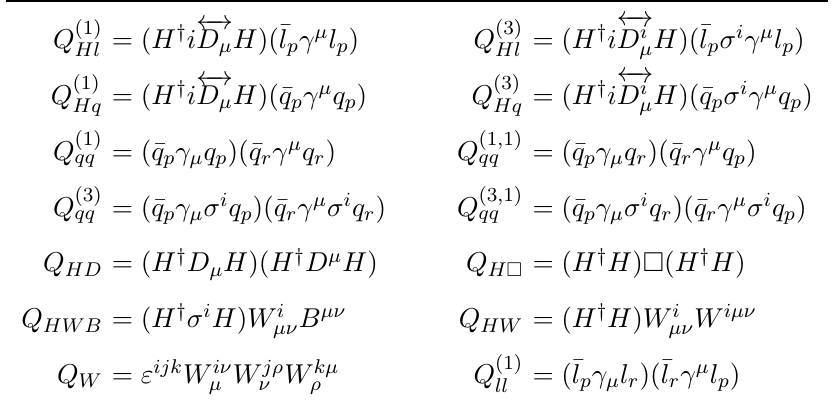
Table 1 . The subset of Warsaw basis operators considered in this work. Repeated indices are understood to be summed over. p, r are flavour indices, and a U(3) 5 -invariant flavour structure is